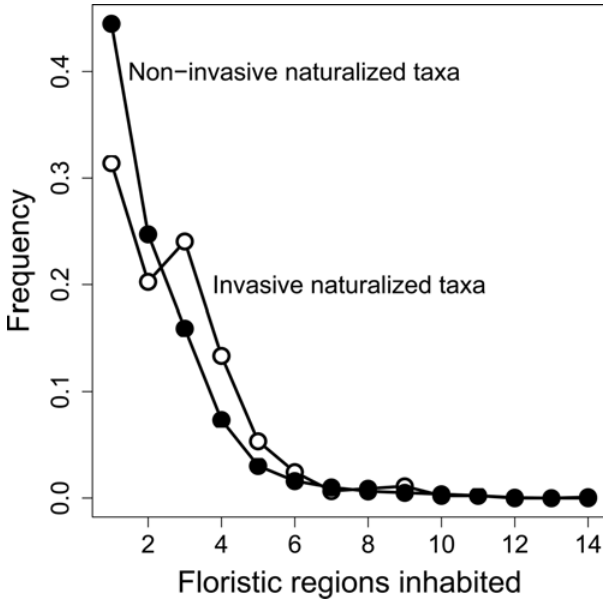
Figure 3. Relative frequency of the number of floristic regions inhabited by invasive and non-invasive alien plants of the Eastern U.S. Non-invasive taxa (N=2180) are indicated by closed dots and invasive taxa (N=449) by open dots. Candidate floristic regions (N=21) are those listed in Table 2. A two-sample Wilcoxon rank sum test indicates invasive taxa span a larger range of native floristic regions than non-invasive taxa (W=585242, P , 0.001).